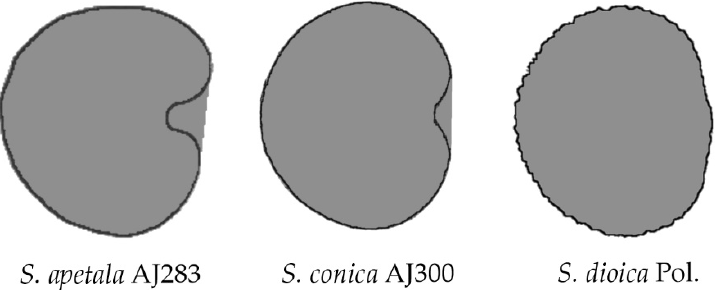
Figure 13. Average silhouettes for the lateral views of 20 seeds of S. apetala AJ283 (smooth seed), S. conica AJ300 (rugose seed), and S. dioica Pol. (echinate seed), with the corresponding convex hull. Table 2. Values of solidity and perimeter ratio (perimeter of the convex hull/ perimeter of the image) in the average silhouettes and as mean of three seeds for the lateral views of the seed images of S. apetala AJ283, S. conica AJ300 and S. dioica Pol. Values marked with the same superscript letter in each column correspond to populations that do not differ significantly at p < 0.05 (Campbell and Skillings’s test). N indicates the number of seeds analyzed.